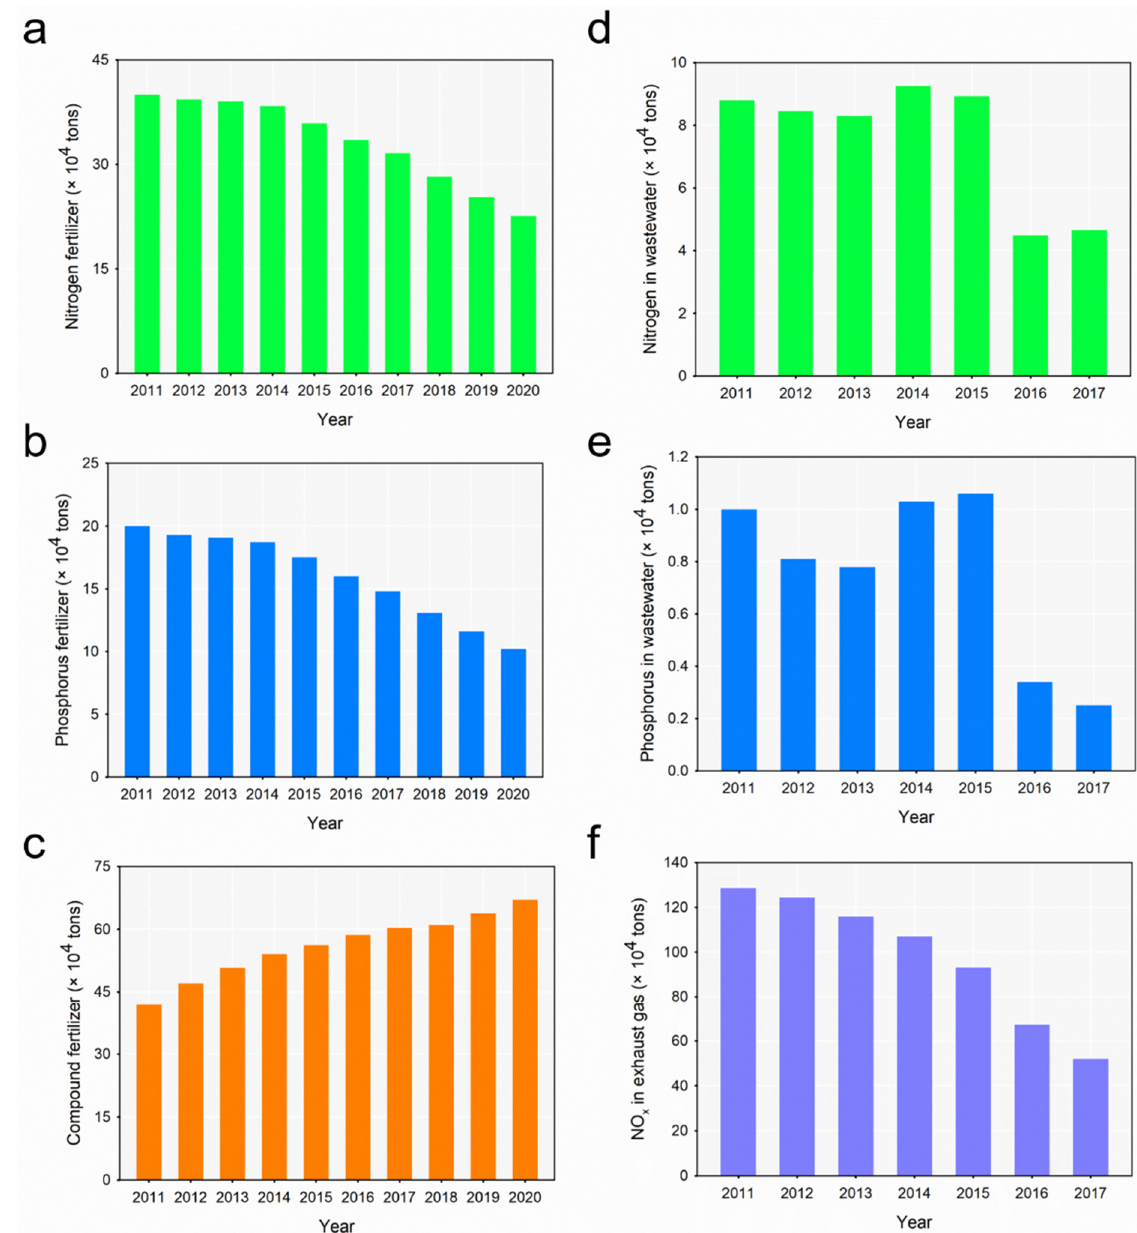
Figure 7. Sources of nitrogen and phosphorus nutrients in Shanxi Province. Application of nitrogen ( a ), phosphorus ( b ), and compound ( c ) fertilizer in 2011–2020; nitrogen ( d ) and phosphorus ( e ) discharge in wastewater in 2011–2017; NO x discharge in exhaust gas ( f ) in 2011–2020.